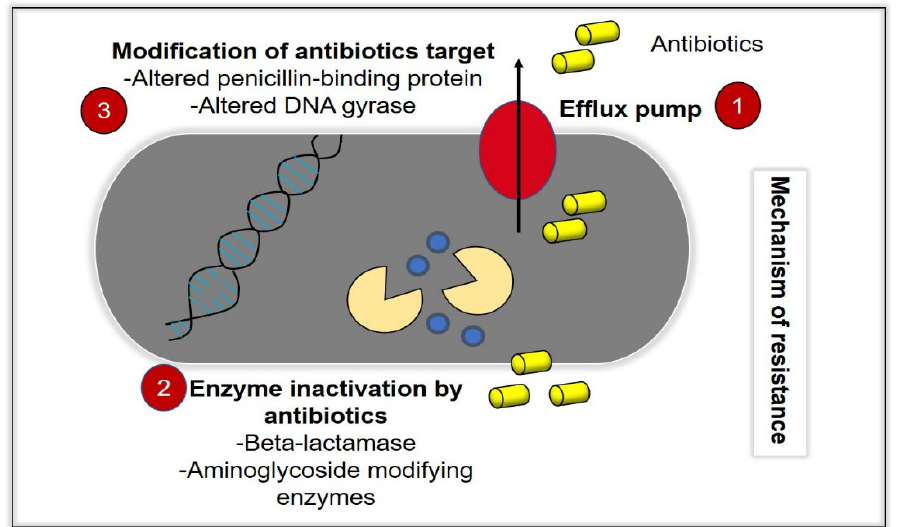
Figure 1. Bacteria acquire resistance toward antibacterial agents (antibiotics) through various mech- anisms. (1) Efflux pump activity, in which the intracellular antibiotics are removed from the bacteria cells, which prevents the accumulation of antibiotics at its therapeutic concentrations, intracellu- larly. (2) Inactivation of enzymes, such as beta-lactamase, and (3) modification of antibiotics targets, such as alterations of the penicillin-binding protein (ABP) and DNA gyrase.